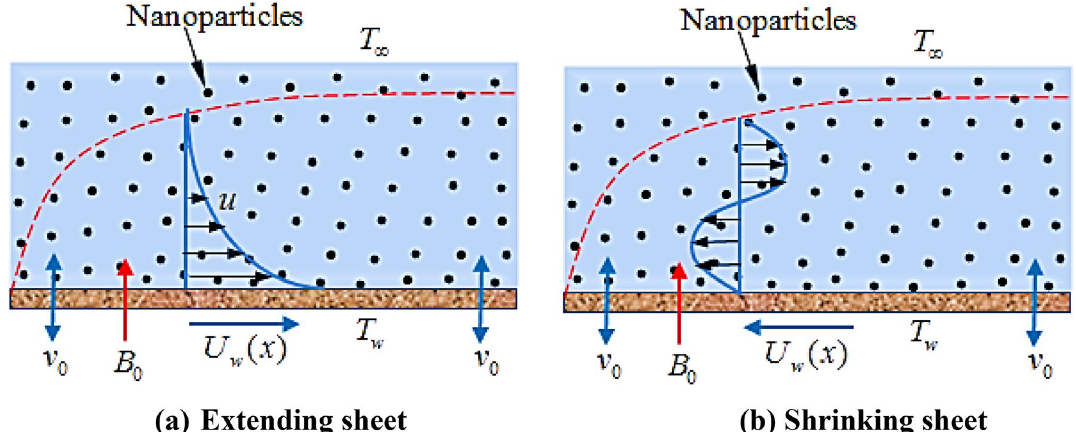
Figure 1. Physical sketch of the flow. Physical